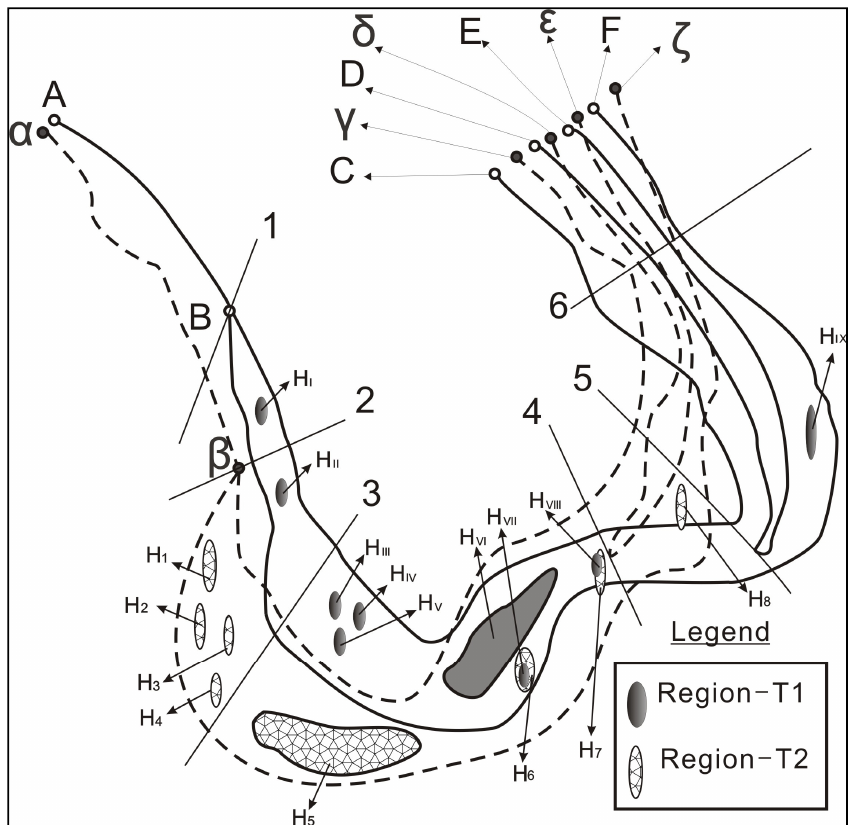
Figure 11. River planform segmentations.